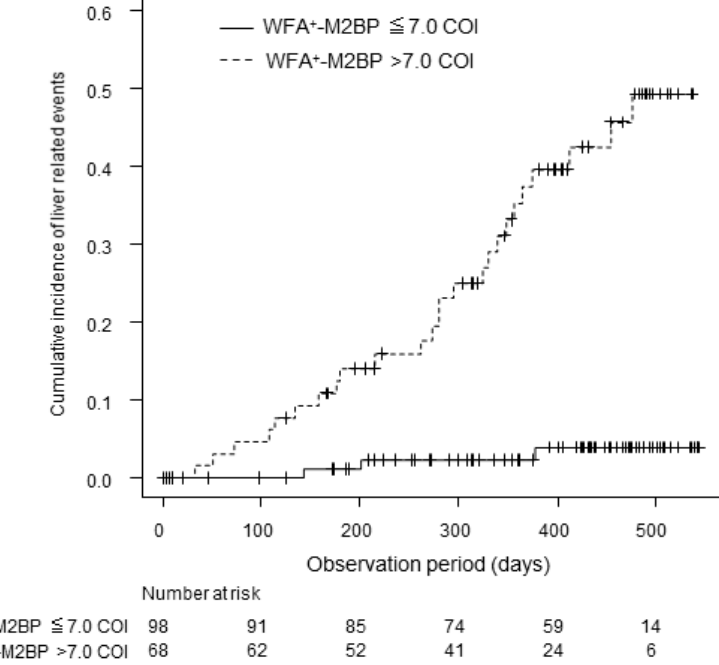
Table 4. Multivariate analysis for liver related events.